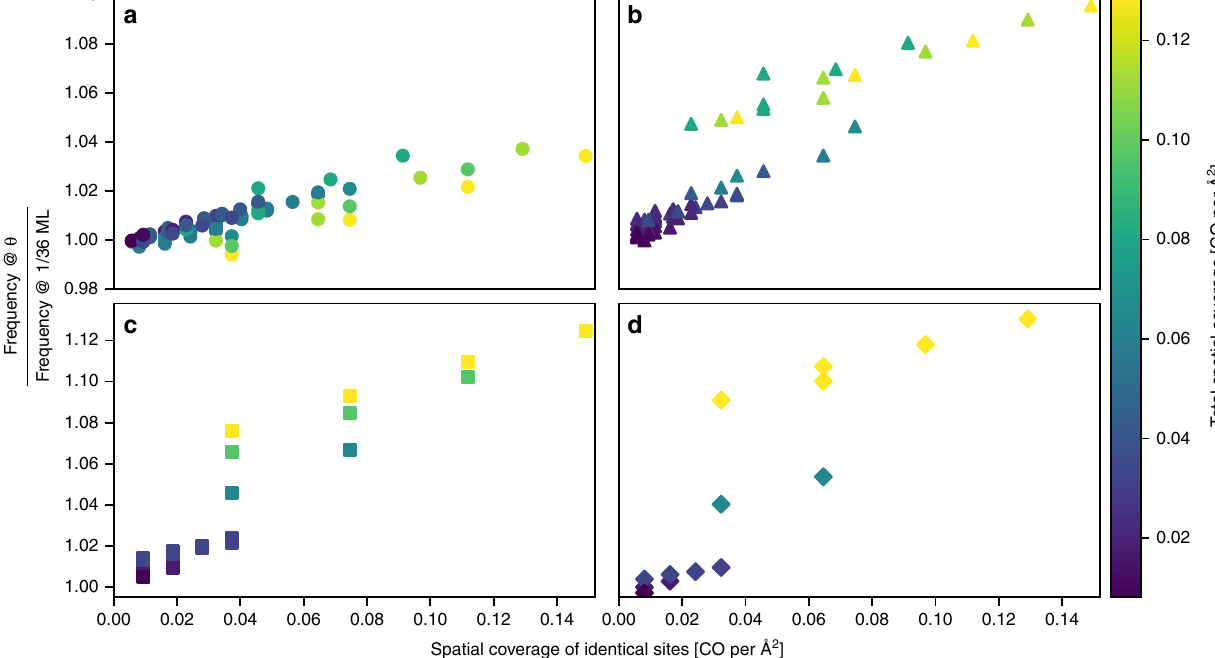
Fig. 4 CO coverage-IR linear scaling relations. Frequency-coverage scaling factors ( y -axis) for atop ( a ), bridge ( b ), threefold ( c ) and fourfold ( d ) hollow sites. Data is regressed using ordinary least squares (OLS) on both site-speci fi c spatial coverage (x-axis) and total spatial coverage (color variation) of CO. The R 2 values of the regression are 0.937 ( a ), 0.966 ( b ), 0.989 ( c ), and 0.965 ( d ). Replacing site-speci fi c spatial coverage with site-speci fi c relative coverage results in better statistical models for the atop and bridge bound species; however, using only spatial coverage in the model allows for enforcing spatial coverage constraints when generating the secondary dataset of synthetic spectra. Data from the 111, 100, and 110 surfaces fall on the same line for each binding-type at either constant total spatial coverage or spatial coverage of identical